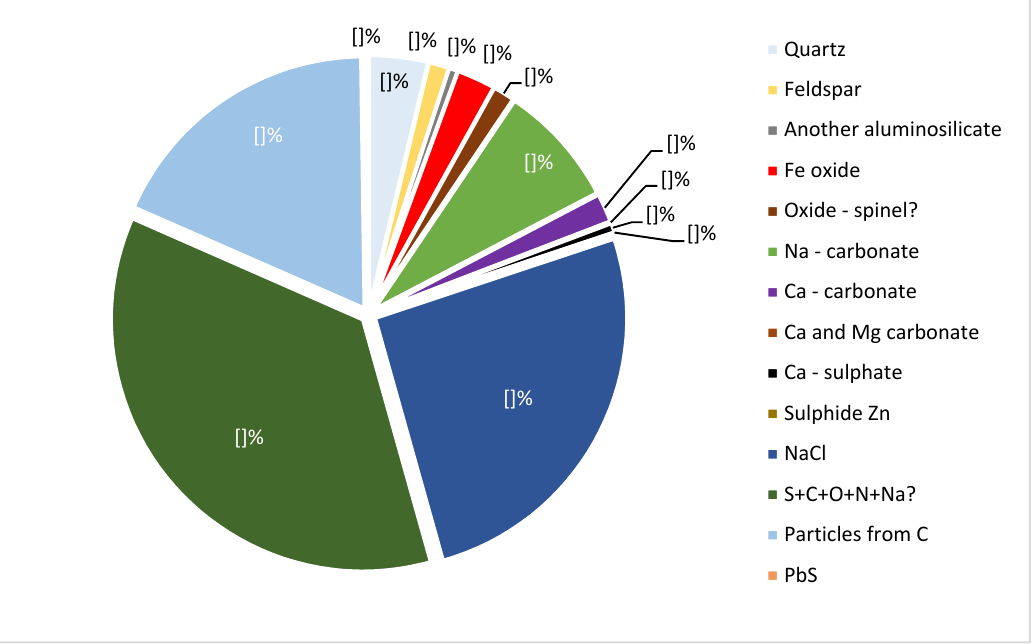
Figure 7. Surface area of grains (2.5 µm) of different components of Pszczyna—Piasek dusts.